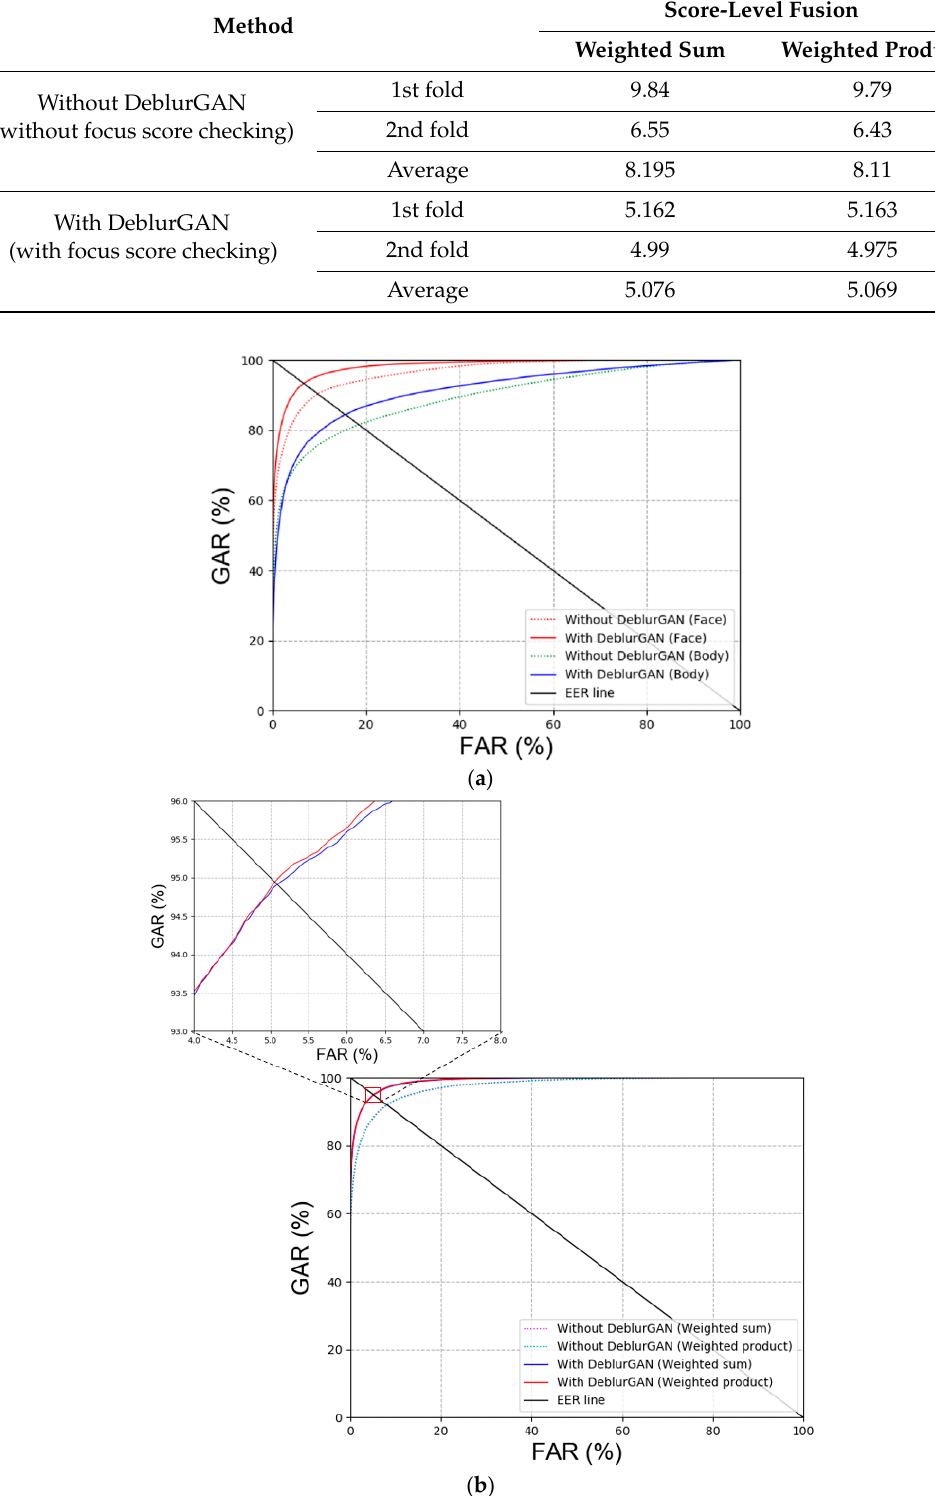
Table 12. Comparisons of EER for recognition by proposed method with that by CycleGAN (unit: %). Method